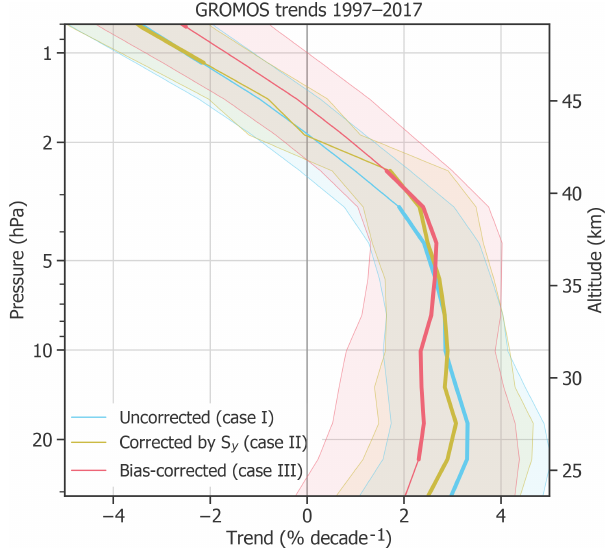
Figure 7. GROMOS ozone trends from January 1997 to De- cember 2017, without considering anomalies (case I), considering anomalies in the diagonal elements of S y (case II), and considering a correlated bias block for anomalies (case III). The shaded areas show 2 σ uncertainties, whereas the bold lines represent altitudes at which the trend profile is significantly different from zero at a 95% confidence interval ( | trend | > 2 σ